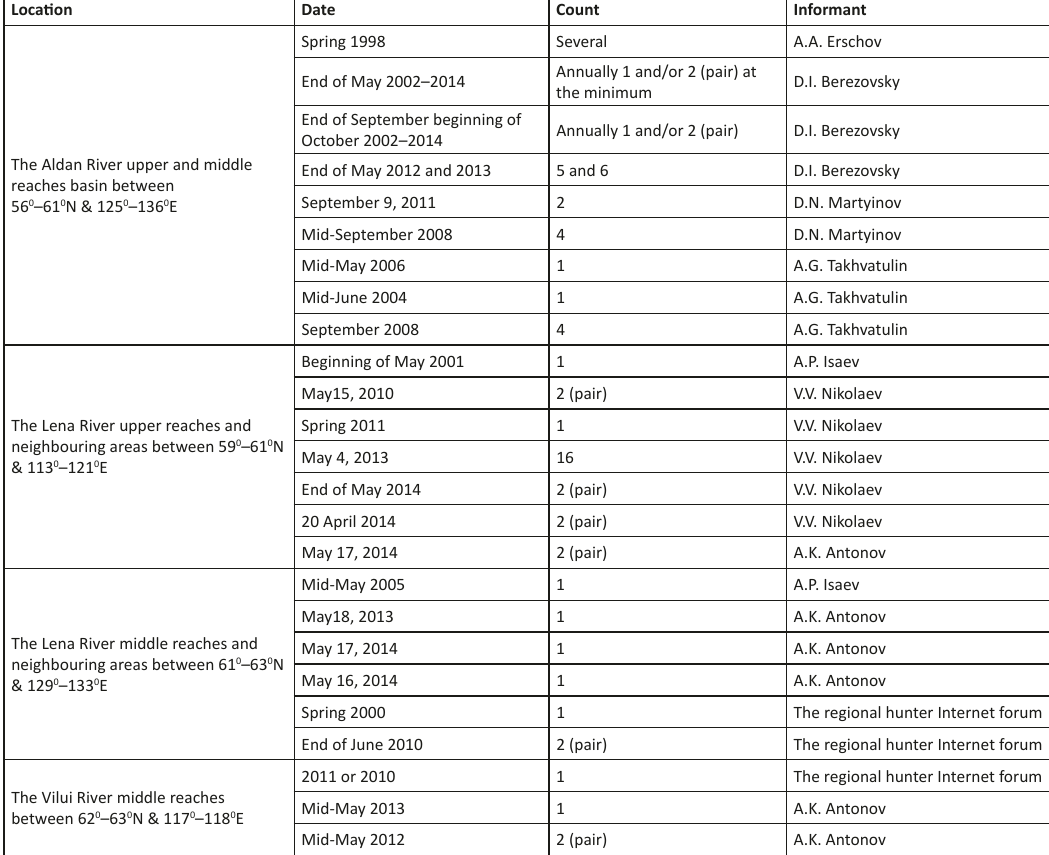
Table 1. The Mandarin Duck occurrences within the bounds of the Lena River